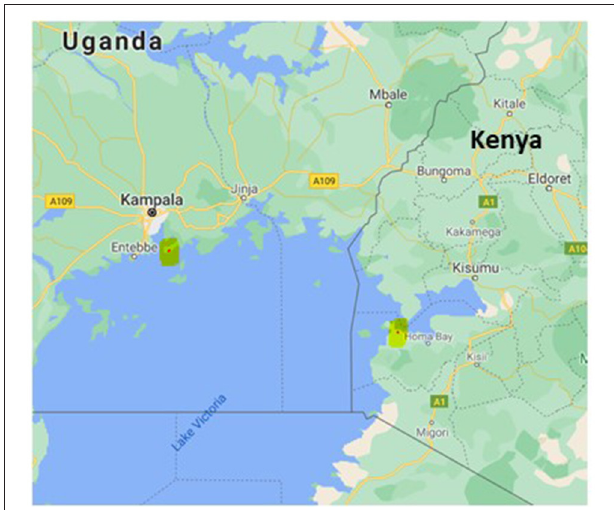
FIGURE 3 | BS (Uganda) and NB (Kenya). Source: Google maps. Authors’ own based on images with “no copyright reserved” (Creative Commons Attribution Non Commercial No Derivatives 4.0 International